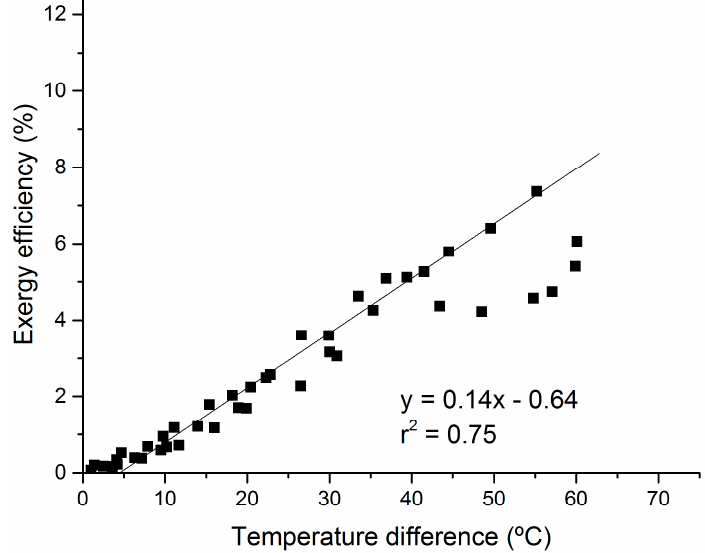
Figure 8. Linear regression curve of the exergetic yield has a positive slope.